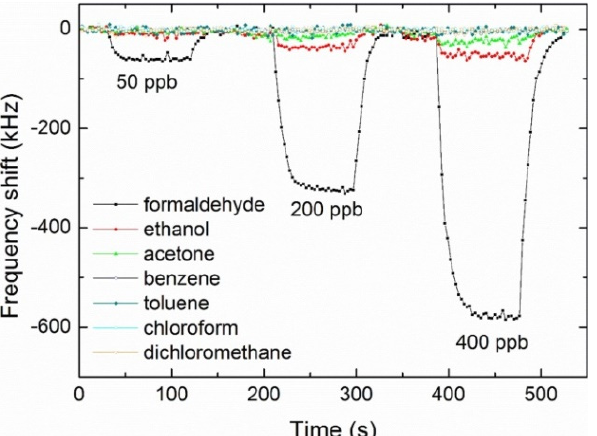
Figure 10. Sensor response of FBAR device coated with polyethyleneimine-modified single walled carbon nanotubes for formaldehyde vapors at 50 ppb, 200 ppb and 400 ppb, measured at 23 °C and 40% relative humidity. Sensor shifts to different interferents such as ethanol, acetone, benzene, toluene, chloroform and dichloromethane were also recorded at concentrations twice high as of formaldehyde, adapted with permission from [109].